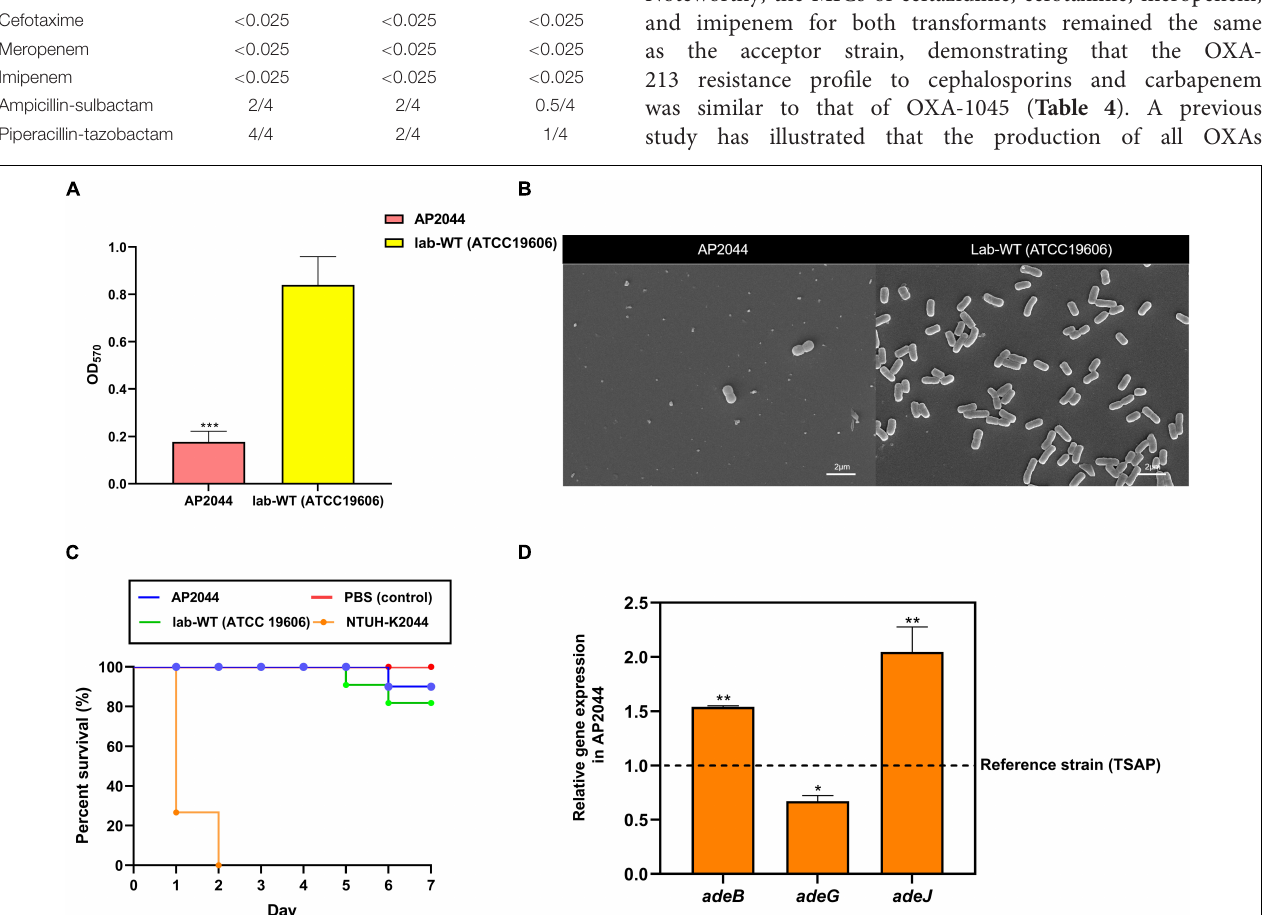
FIGURE 3 | (A) Crystal violet quantification of biofilm formation in the AP2044 and Lab-WT strains; Lab-WT was used as positive control and LB broth was used as negative control. (B) SEM images of the AP2044 and Lab-WT strains. (C) To compare pathogenicity in vivo , 15 Galleria mellonella larvae were infected with the common strain Lab-WT, typical hypervirulent strain NTUH-K2044, and strain AP2044 under each condition. Death was defined as a lack of reaction or melanization in infected G. mellonella at 37 ◦ C for 7 days. The mean ( N = 15 biological replicates) is represented for the data. (D) The expression of adeB , adeG , and adeJ genes was quantified via qRT-PCR. Gene expression profiles of the strains were normalized to their respective 16S rRNA expression. Data represent the mean ( ± standard deviation, SD ; N = 4–6 biological replicates). * P < 0.05; ** P < 0.01; *** P < 0.001 by Student’s t -test against theoretical value.